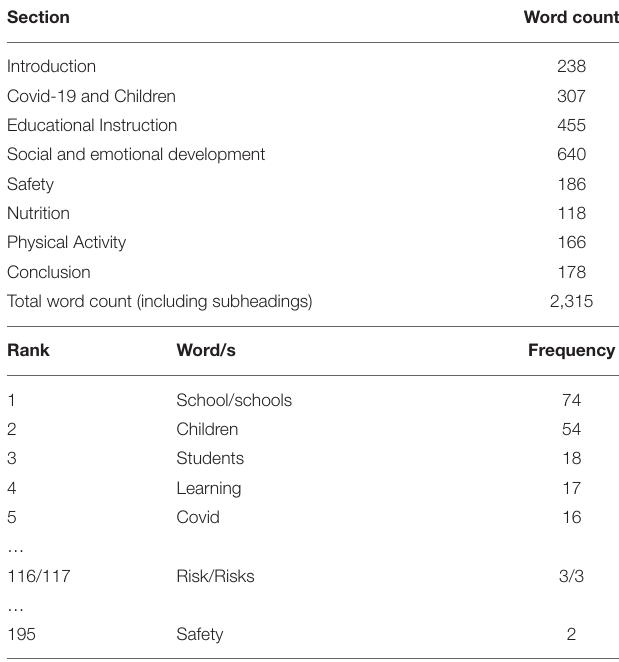
TABLE 1 | Document sections and respective word count/ranking and frequency of selected words in the CDC statement (excluding footnotes).